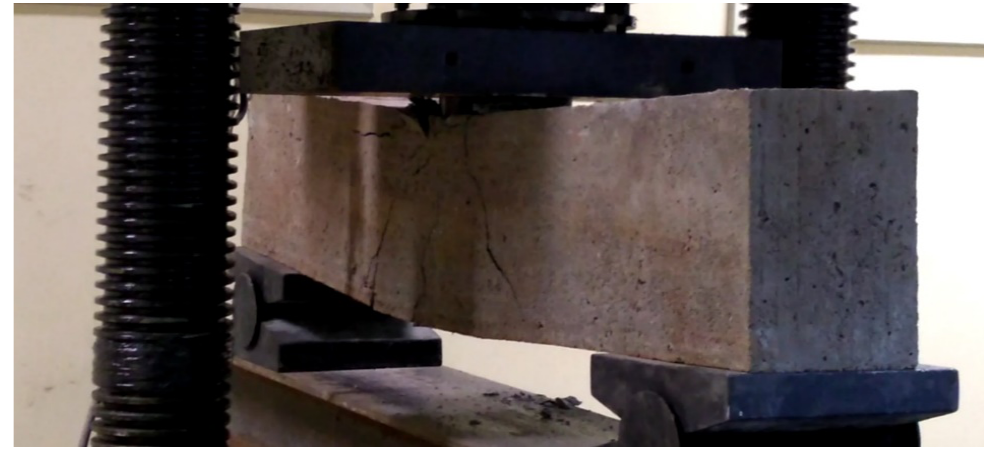
Figure 10. Rupture of beam VA57.